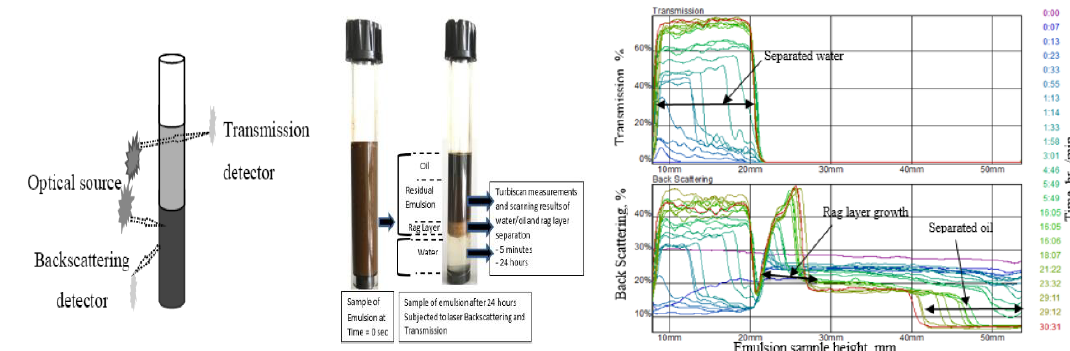
Figure 2. Schematic of the Tuberscan device for light measurements and experimental measurement of separation from emulsion sample; deliberate profiles of the transmission and backscattering rate for emulsion as a function of